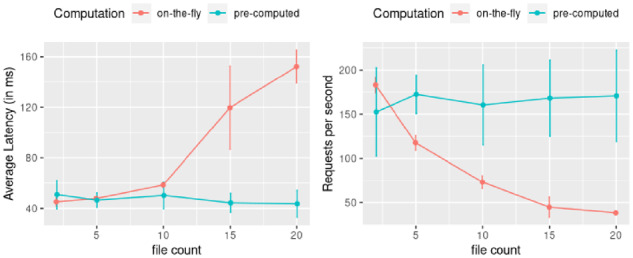
Impact of computing transformations at run time. We measure the overhead in computing transformations lazily (on-the-fly) versus querying a file that stores the pre-computed result. We measure the average latency and requests processed per second by the system across five different runs and the shows the mean and standard deviation for these metrics. The results indicate the latency of the system increases as we increase the number of files involved in the computation, hence lowering the number of requests processed per second